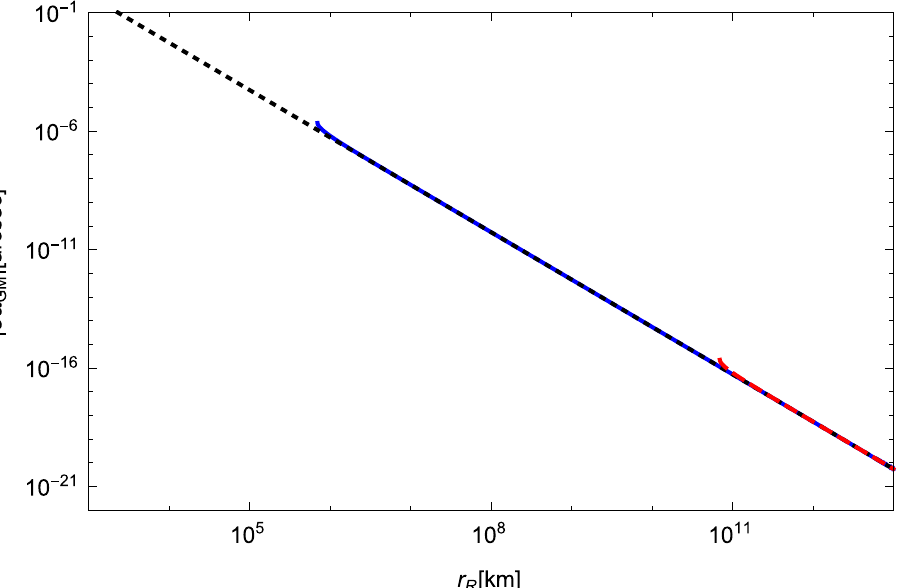
Figure 11. δα GM for the Sun: The horizontal axis is the distance of the receiver distance r R . The vertical axis means the finite-distance correction due to the gravitomagnetic deflection angle of light. The solid curve (blue in color) and dashed one (red in color) denote b = R (cid:12) and b = 10 5 R (cid:12) , respectively. The dotted line (black in color) corresponds to the leading term in δα GM given by Equation (124). These three curves are overlapped. This implies the very weak dependence of δα GM on b .